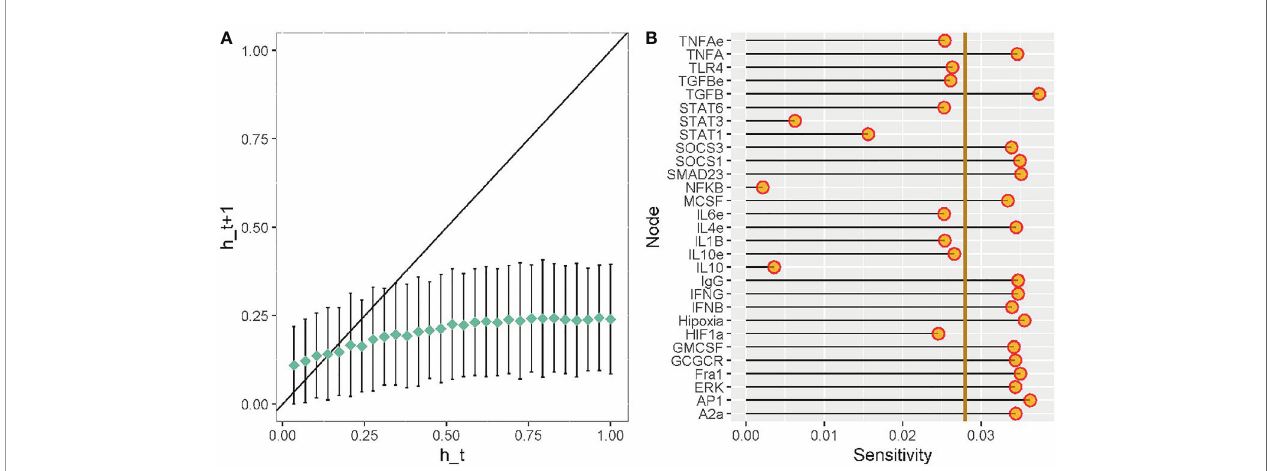
FIGURE 8 | Robustness analysis of our transcriptomic regulatory network of macrophage polarization. Sensitivity analysis of each node from our transcriptional regulatory network of macrophage polarization. (A) Derrida curves of our transcriptional regulatory network of macrophage polarization in a tumor microenvironment. (B) Sensitivity analysis of the variables in our transcriptional regulatory network of macrophage polarization in a tumor microenvironment. Golden line is the mean of the value of the sensitivity